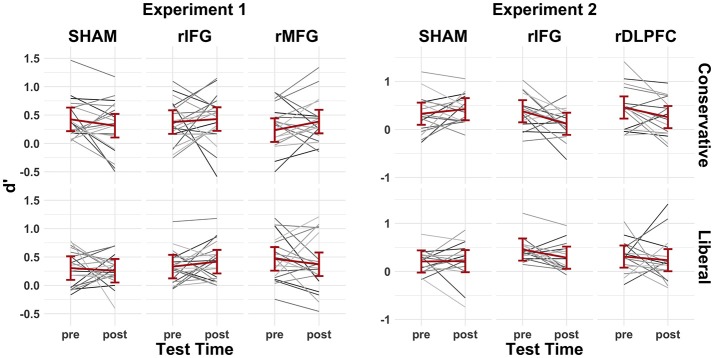
The pre-/post-cTBS'd values for Experiment 1 (left) and Experiment 2 (right). Gray lines indicate individual subject performance and red lines represent group averages fitted with 95% confidence intervals.